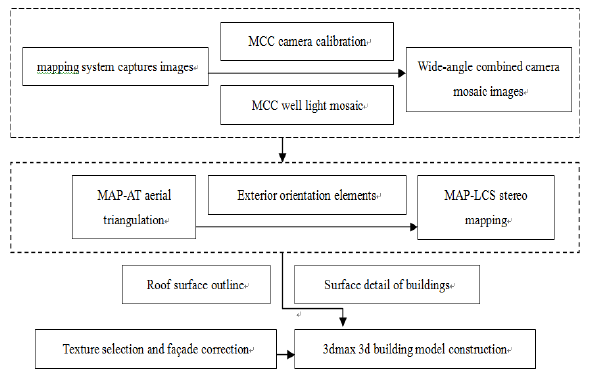
Figure 1. 3d modeling flow chart